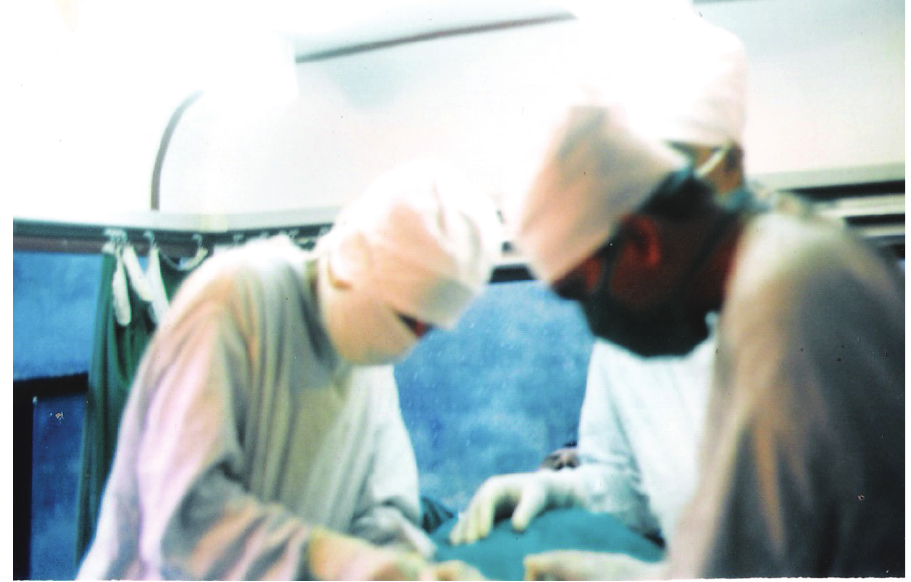
Figure 4 : Surgery in progress in mobile